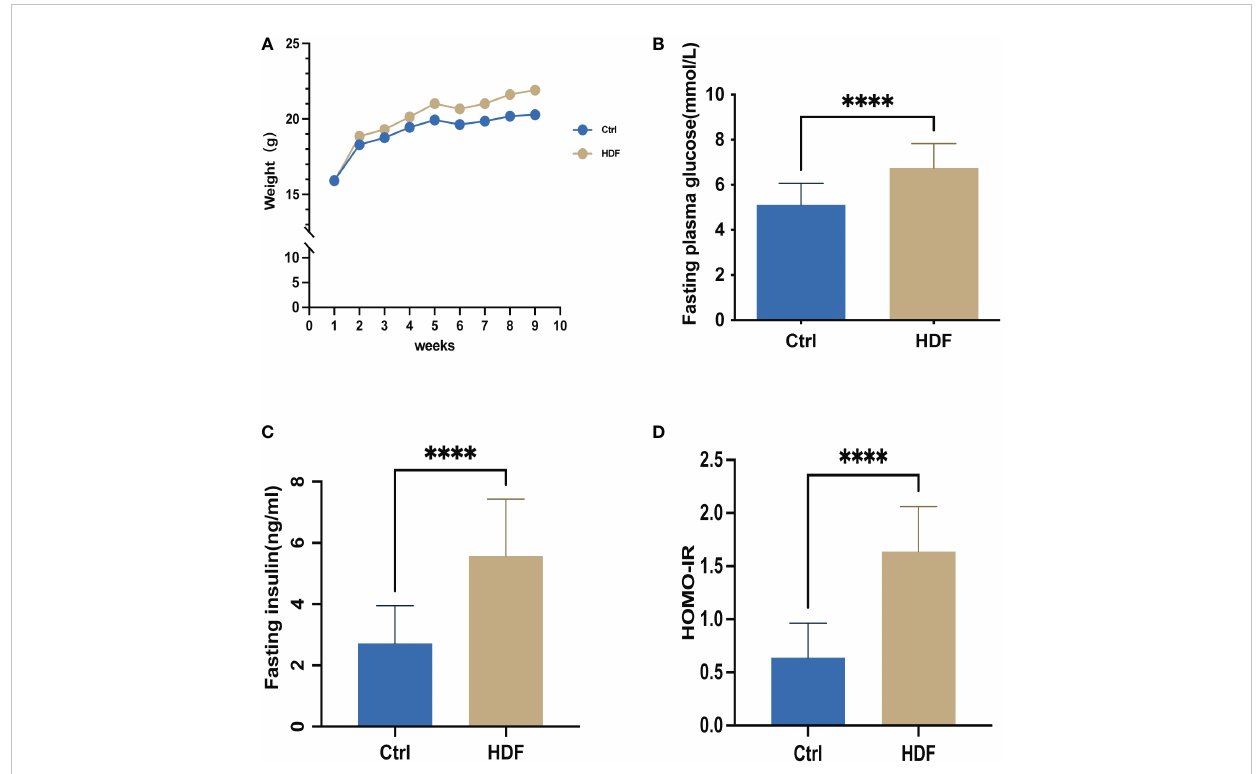
FIGURE 1 The insulin-resistant mouse model was successfully established. Control group: C57BL/6 mice were fed with a standard diet for 9 weeks; HDF group: C57BL/6 mice were fed with a high fat diet for 9 weeks, respectively. To validate that the insulin-resistant mouse model was successfully established, weight, fasting plasma glucose, and fasting insulin levels in the mice were assessed. (A) Weight (B) Fasting plasma glucose after 12 h of fasting was determined at the same time point each week, for 8 weeks. n=14 in each group; t-test. (C) Fasting insulin concentration was determined by ELISA after 12 h of fasting, n=14 with one repeat in each assay; t-test. (D) The HOMA-IR insulin resistance index was calculated, n=14 with one repeat in each assay; t-test. ****:P<0.0001 compared to group “ Ctrl ”